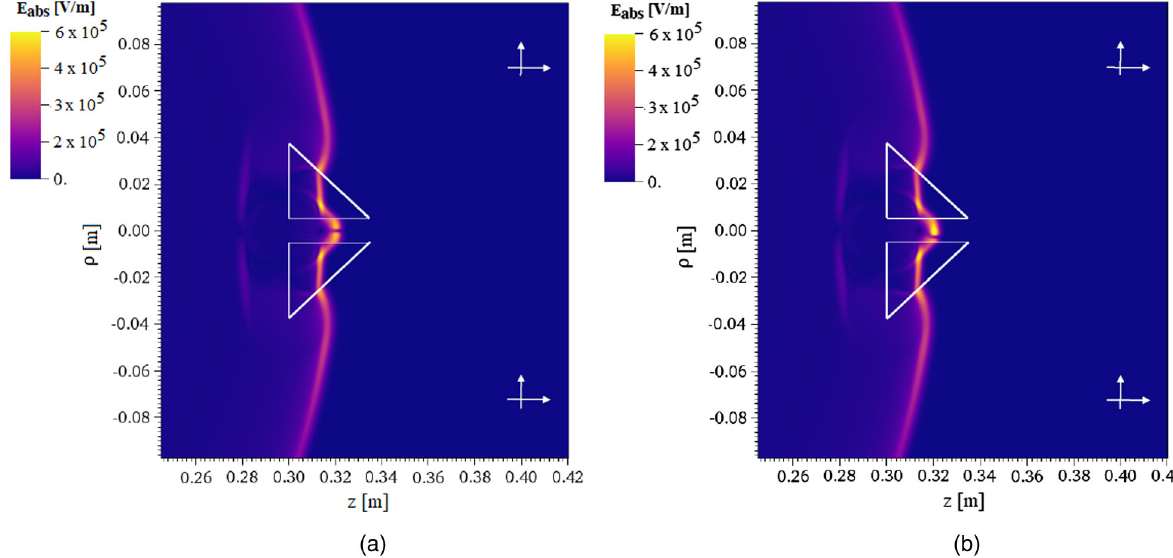
FIG. 5. Simulations of electron bunch propagation in the hollow channel of the dielectric prism for a on-axis (a) and a off-axis (b) beam. Detectors positions in the propagation plane are marked by white